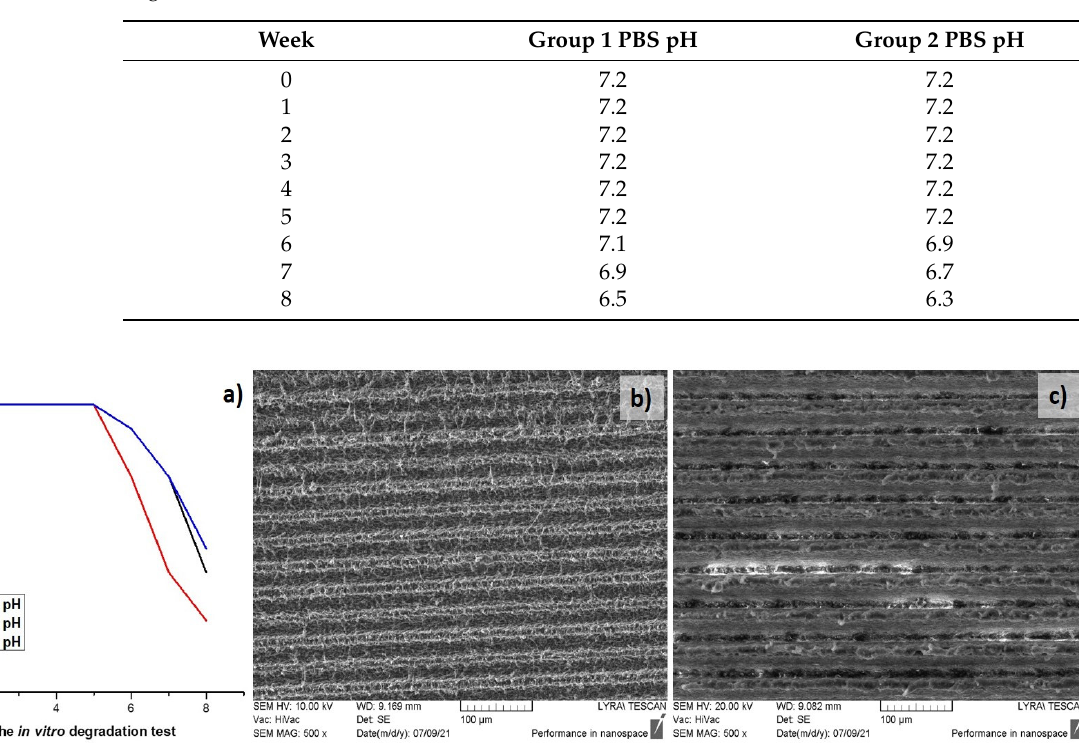
Table 3. pH change of PBS of Group1 (G1)—PLA F = 0.8 J/cm 2 , V = 3.8 mm/s; Group2 (G2)—PLA F = 1.7 J/cm 2 , V = 0.6 mm/s and Group3 (G3)—control PLA during the 8 week period of in vitro